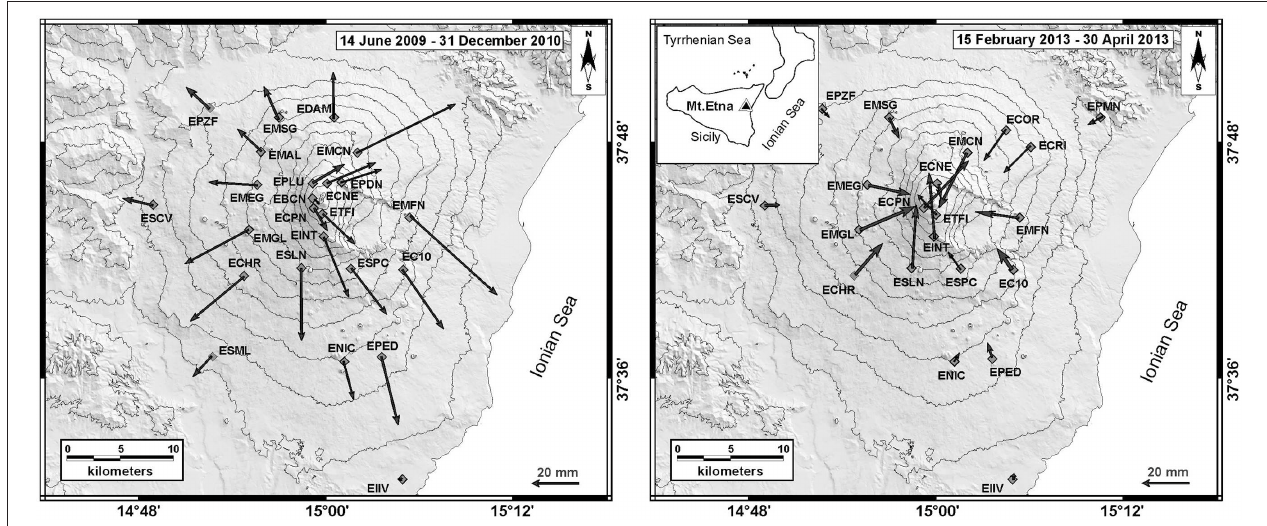
FIGURE 6 | Typical deformation patterns recorded at Mount Etna: inflation during a recharge phase ( left ) and deflation during an eruptive phase discharging phase ( right